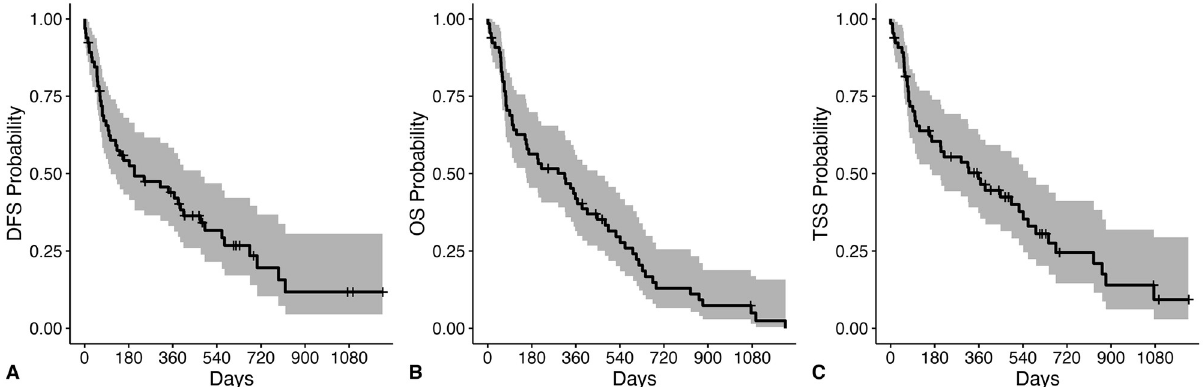
Fig 3. Outcome for all dogs with primary lung tumors following surgical resection. Disease-free survival (DFS), overall survival (OS), and tumor- specific survival (TSS) curves in 65 dogs with primary lung tumors following surgery. Ticks represent dogs censored from analysis and shaded regions represent the 95% confidence interval (CI). Dogs were censored from DFS if they were free of disease at the time of last follow-up. Dogs were censored from TSS if they were alive at the time of last follow-up or died due to a known cause unrelated to a lung tumor. (A) The median DFS was 204 days (CI: 106–474 days). (B) The median OST was 315 days (CI: 157–448 days). (C) The median TSS was 358 days (CI: 168–561